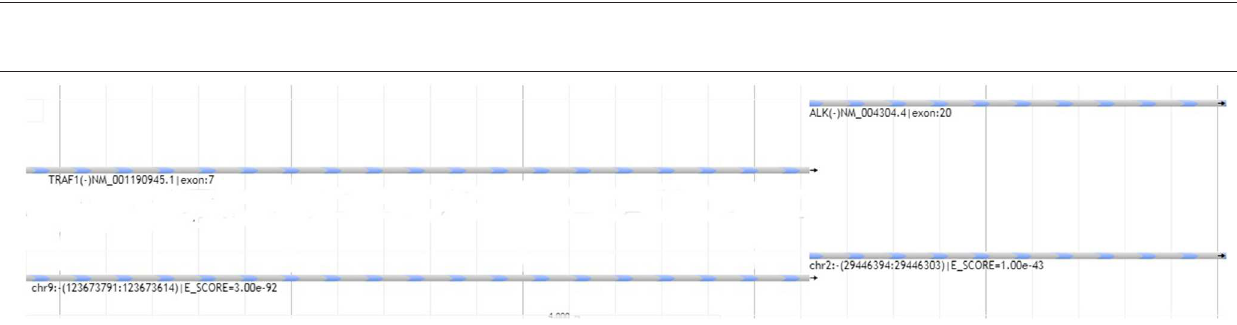
Frontiers in Oncology | www.frontiersin.org